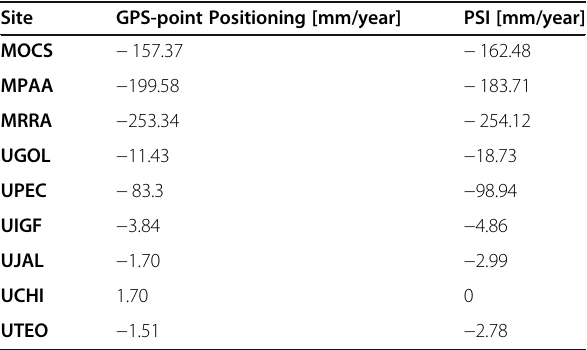
Table 3 Comparisons of LOS ’ rates of movements for GPS and PSI